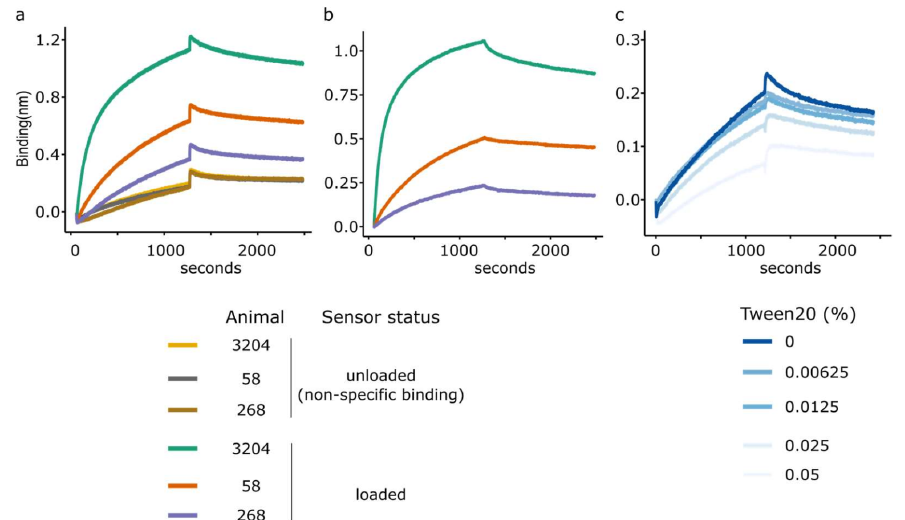
Figure 4. Non-specific binding (NSB) to Octet biosensors. ( a ) Un-referenced BLI associa- tion/dissociation curves indicating the difference between the loaded and unloaded sensors (dark colours) highlighting NSB for three bovine sera (3204, 58 and 268). ( b ) Double referenced curves following the subtraction of the unloaded reference sensors. ( c ) Non-specific interactions in serum from sample 3204 (diluted 1:100) with unloaded sensors in kinetics buffer modified with various concentrations of Tween 20 giving a range of